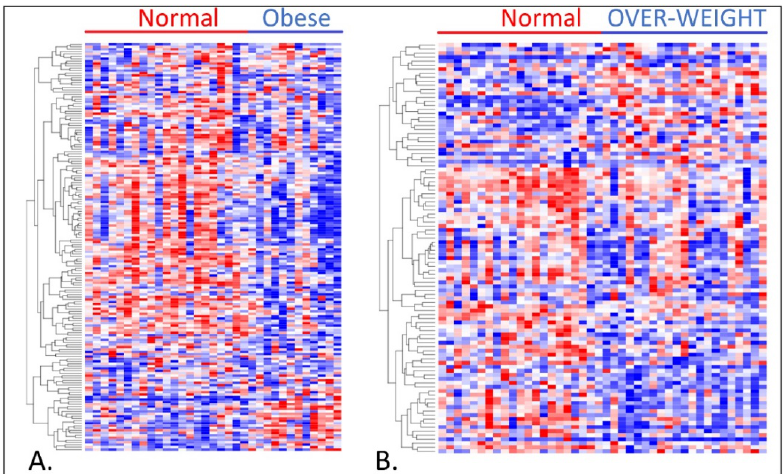
Figure 3. ( A ) Patterns of gene expression profiles for the 171 genes associating obesity with TNBC in premenopausal women. ( B ) Patterns of gene expression profiles for the 102 genes associating overweight status with TNBC premenopausal women. Genes in rows and patients in columns. Red color indicates upregulated and blue color indicates downregulated. Int. J. Environ. Res. Public Health 2018 , 15 , x